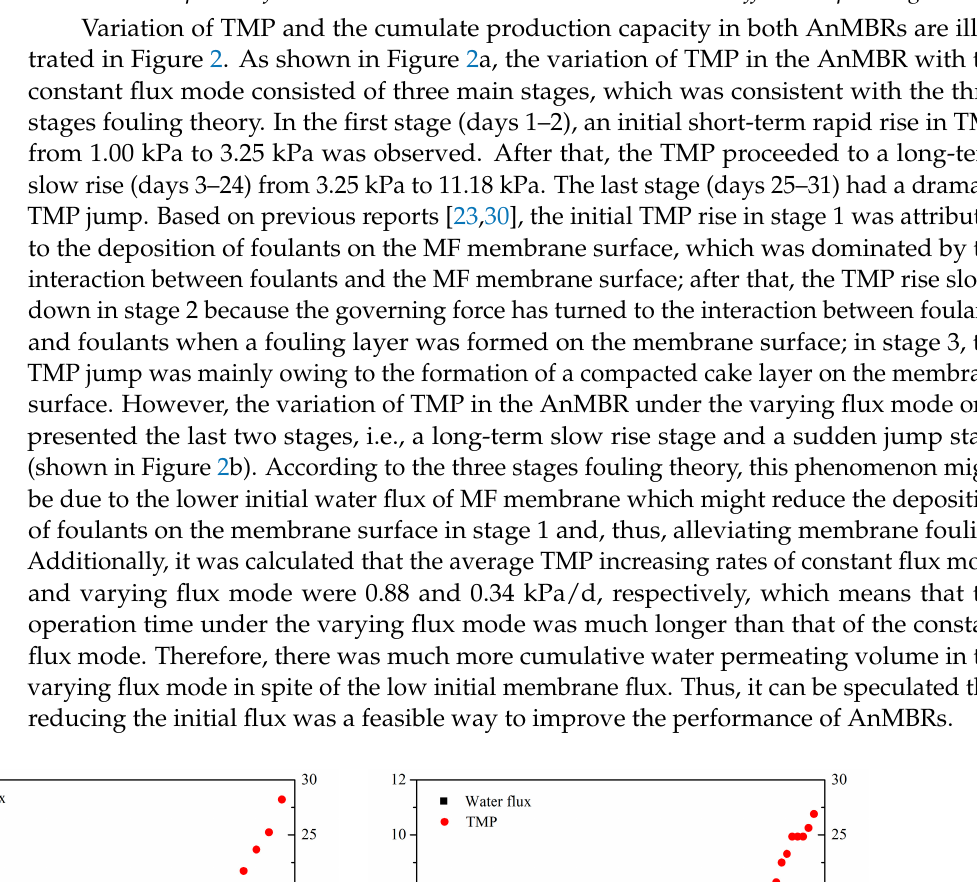
Table 1. COD, TP, and NH 4+ -N concentrations in MF permeates and the removal performances at different operating modes.